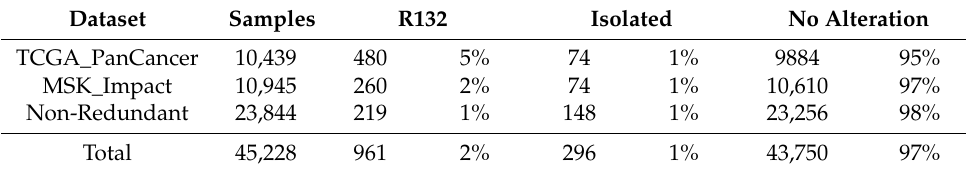
Table 1. Occurrence and frequency of IDH1 alteration in human